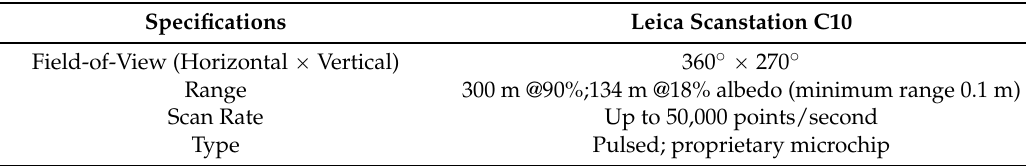
Table 1. Laser scanner specifications.